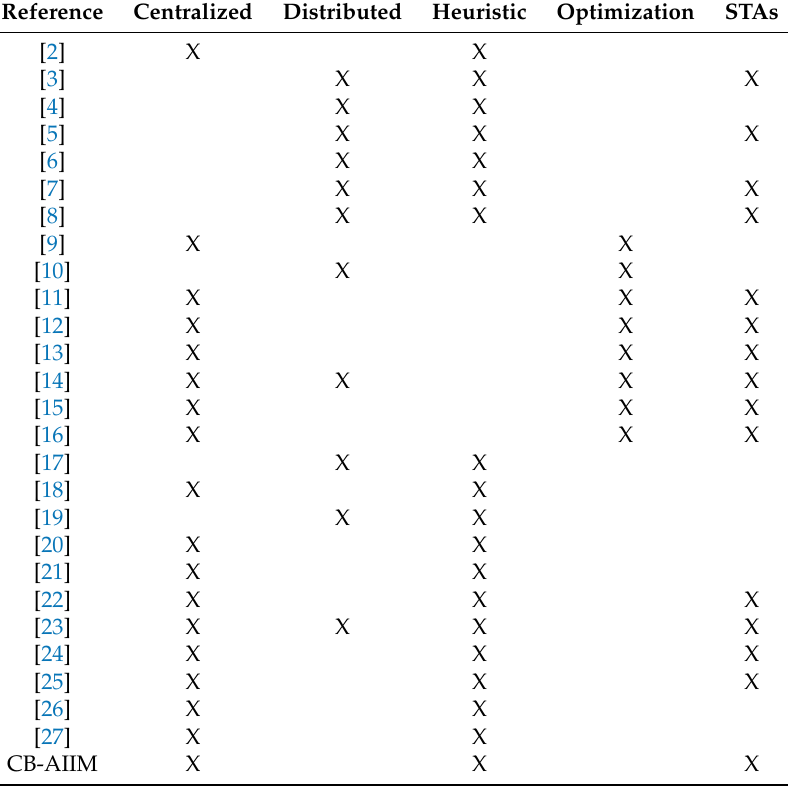
Table 1. Summary of channel assignment techniques in